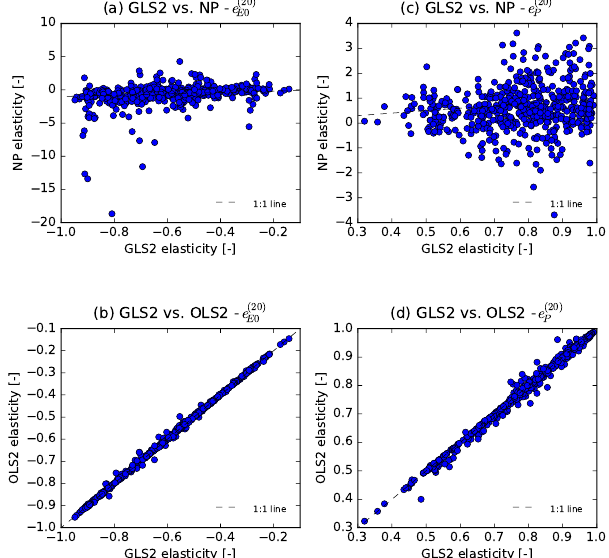
Figure 7. Comparison of elasticity estimates obtained with the GLS2, OLS2 and NP methods using synthetic flow data and 20- year